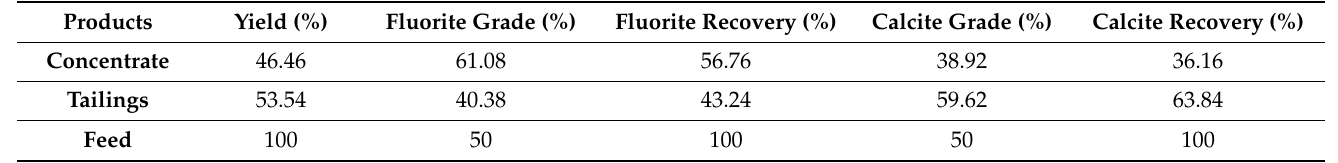
Table 2. Microflotation results for artificial mixed ore after NaF pretreatment.